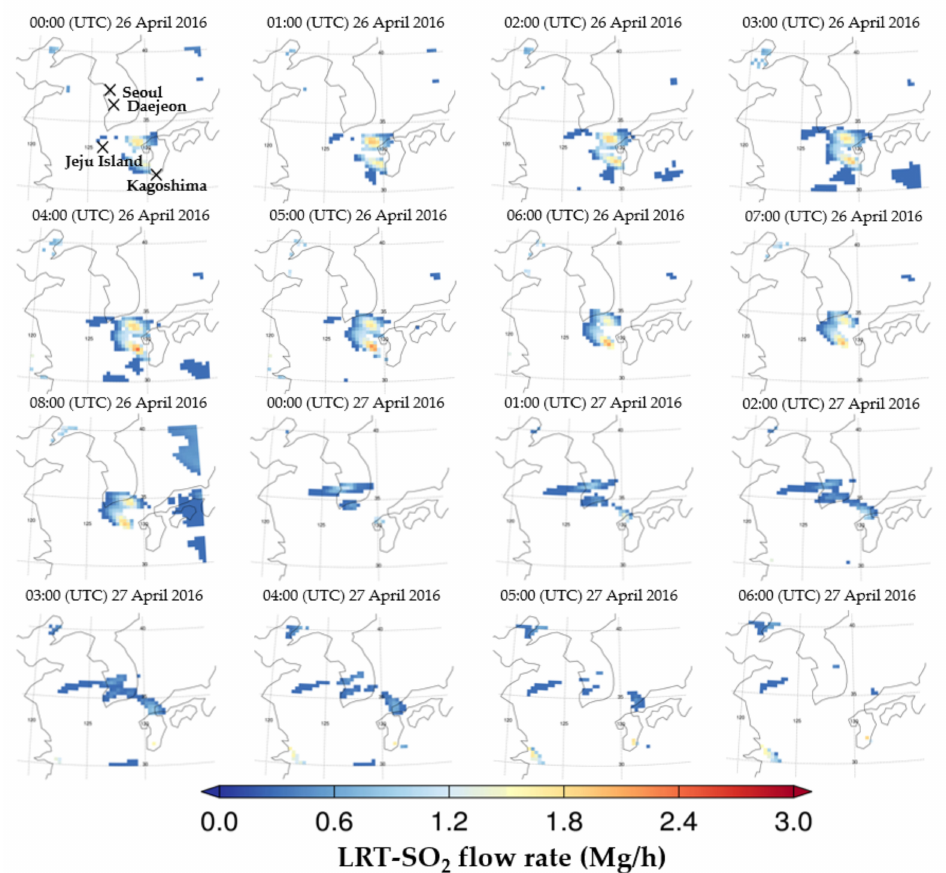
Figure 15. Calculated LRT-SO 2 flow rate for the period of event 1 (26–27 April 2016) considering the uncertainty with wind data and SNR of 1440